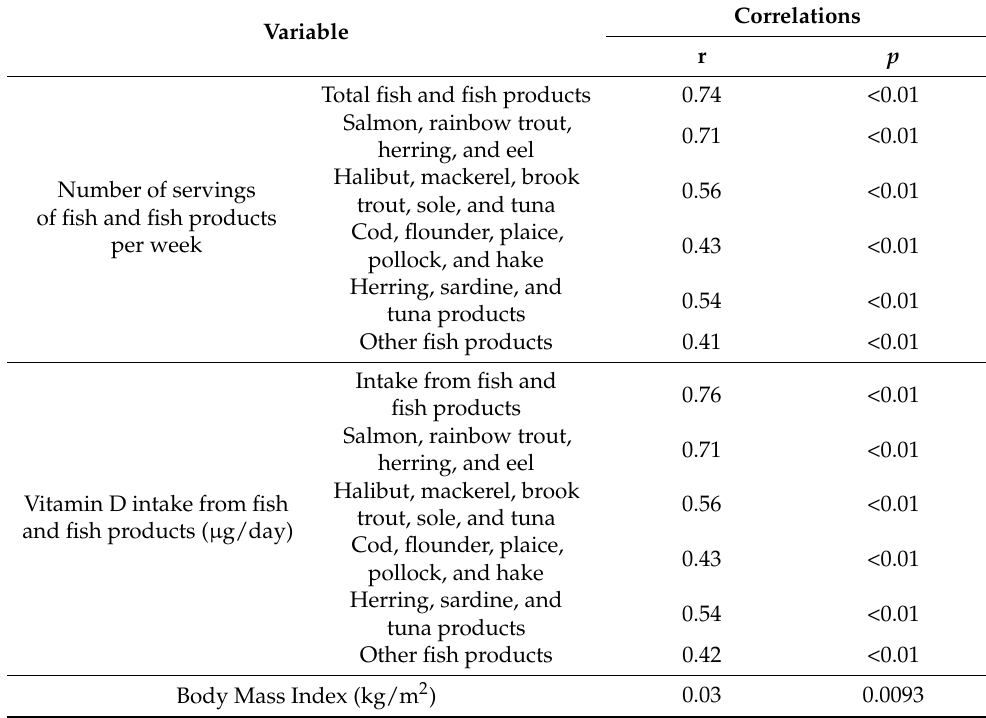
Table 8. The correlations between the declared number of servings of fish and fish products per week and vitamin D intake from them, and BMI and total dietary vitamin D intake in the group of female post-primary school students. Variable